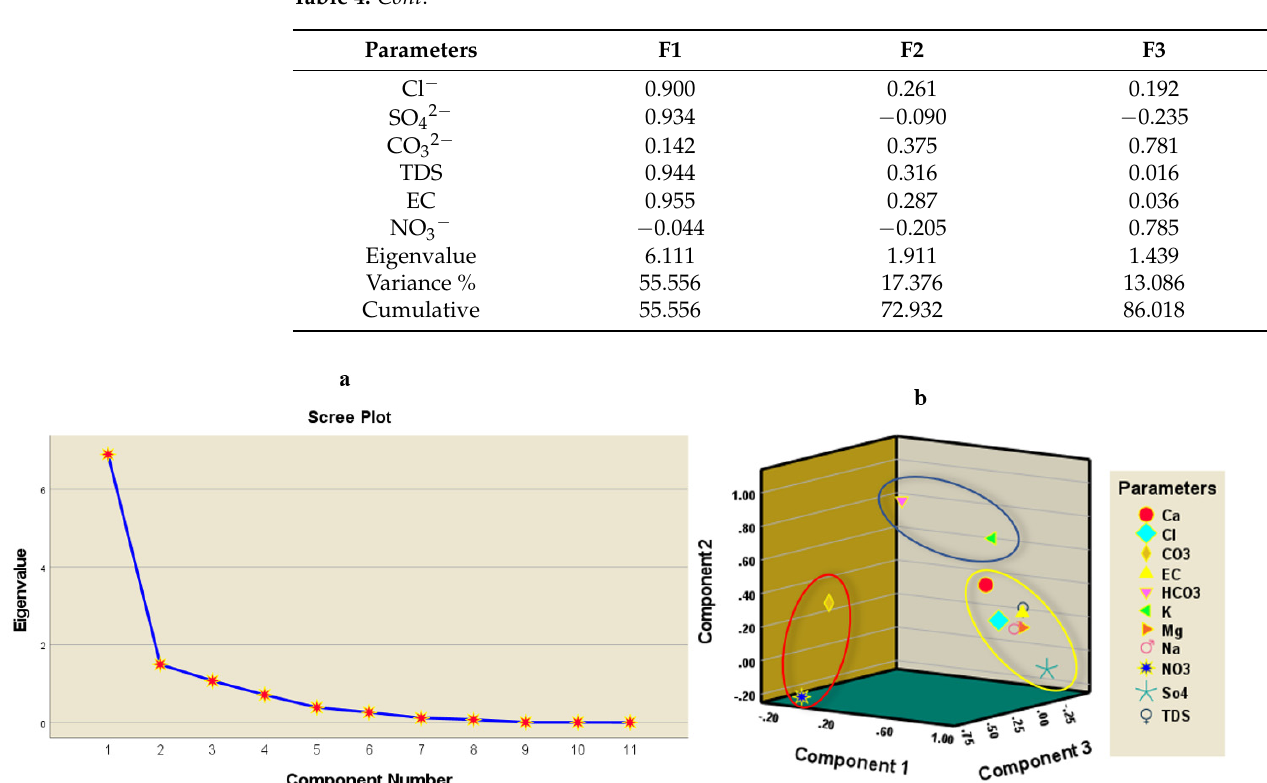
Figure 12. Multivariate statistical analysis: ( a ), Scree plot and ( b ) PCA scores for F2 vs. F1 vs. F3.